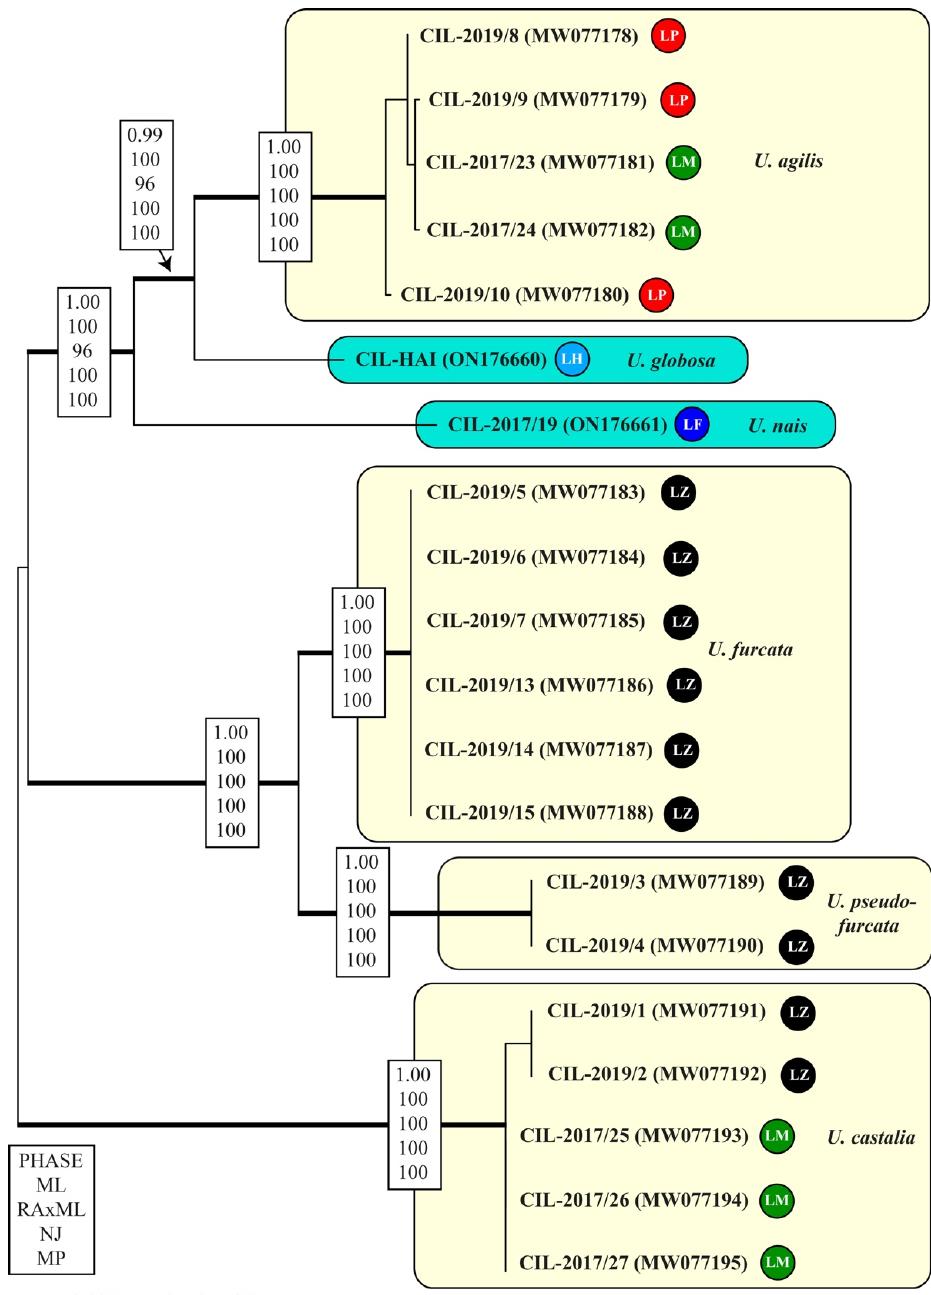
Figure 3. Molecular phylogeny of the genus Urotricha inferred from SSU and ITS rDNA sequences, using the maximum likelihood method of PAUP 4.0a169 on a dataset with 2375 aligned positions of 20 taxa. For the analyzes, the best model was calculated with automated model selection tool implemented in PAUP. The setting of the best model was given as follows: GTR + I + G (base frequencies: A 0.3053, C 0.1670, G 0.2126, U 0.3151; rate matrix A-C 1.5642, A-G 2.1281, A-U